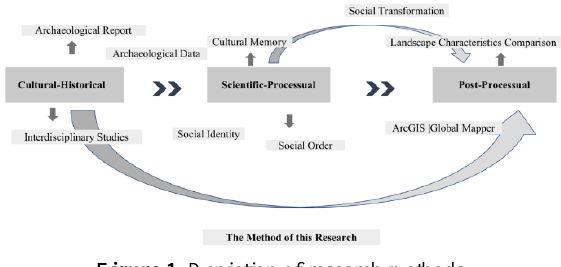
Figure 1. Depiction of research methods.